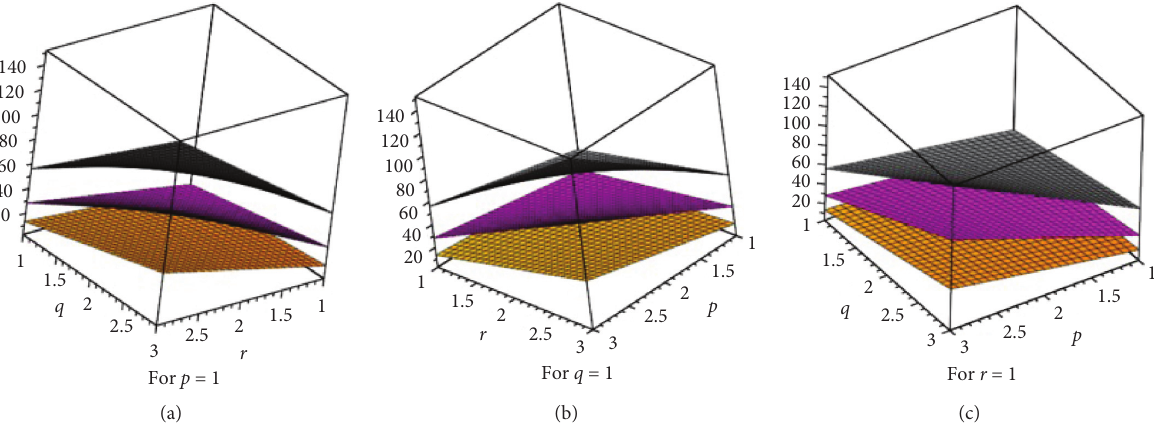
Figure 13: Comparison of IRLU , IRLA, and IRLF for crystallographic structure of titanium difluoride T